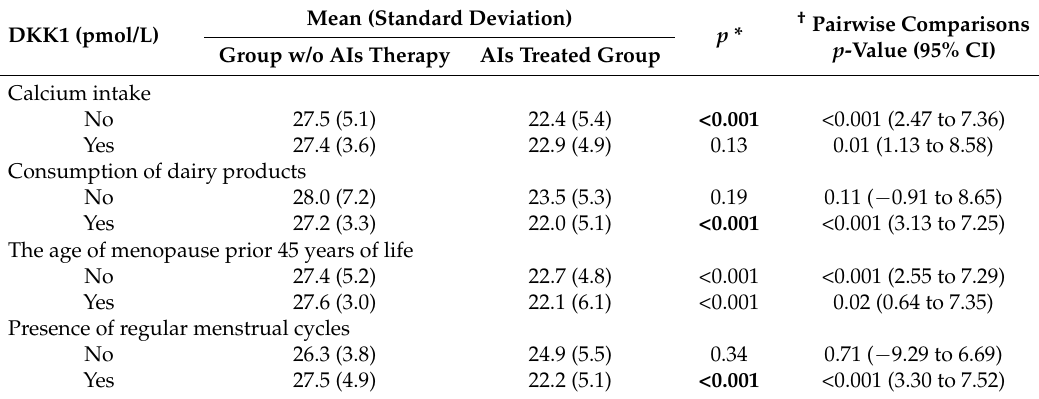
Table 3. Differences in serum levels of DKK1 according to the examined lifestyle parameters between the AI-treated and AIs non-treated group of patients (adjusted for smoking, vitamin D intake, exercise and exercise in the